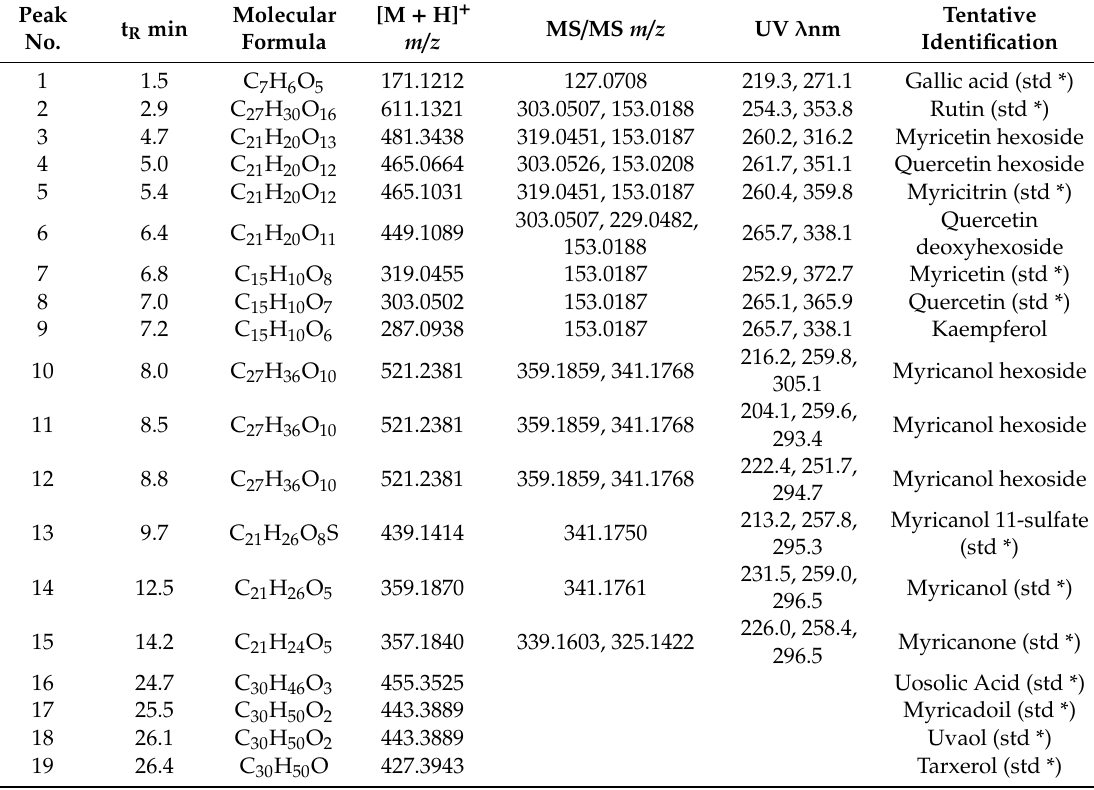
Table 1. Information of the 19 tentative identified compounds from the MRB